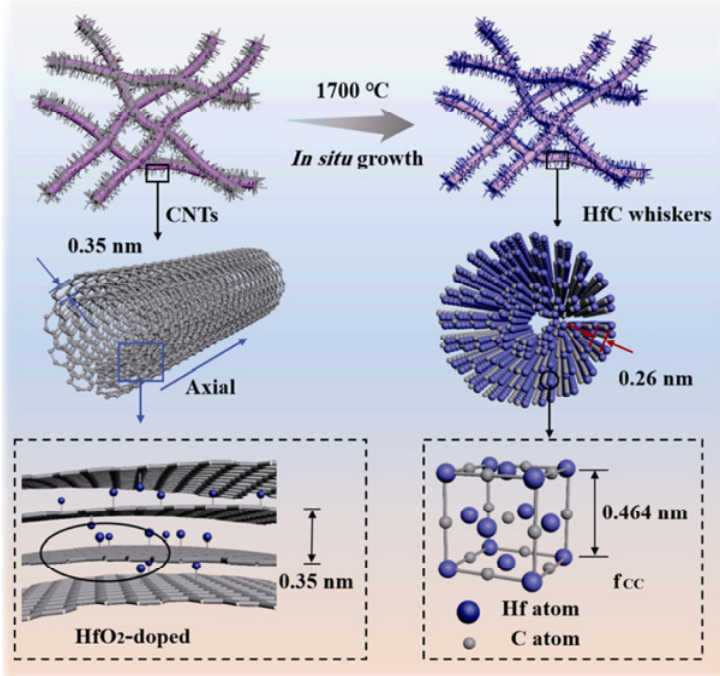
Fig. 7 Schematic diagram of the growth of HfC